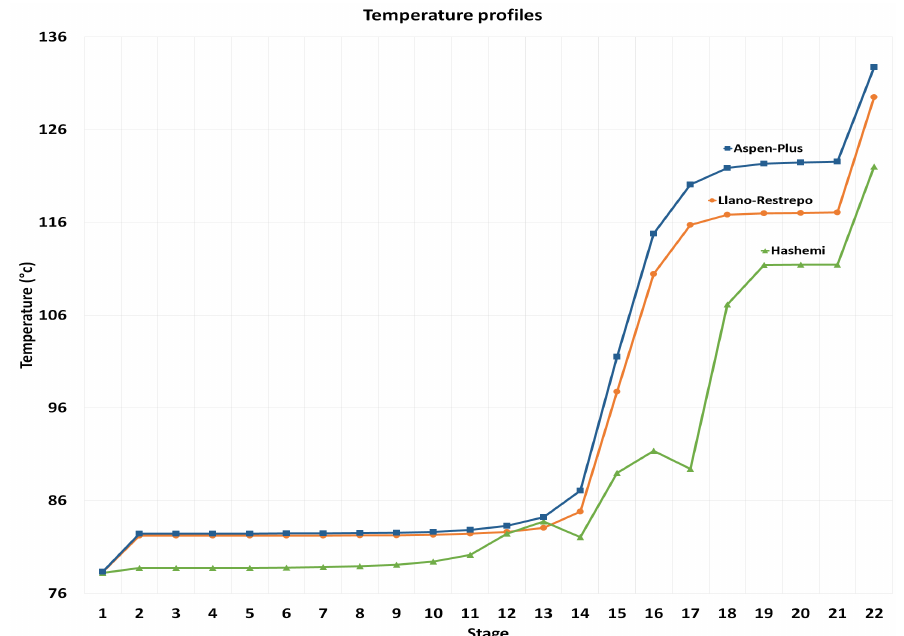
Figure 2. Temperature profiles of the salt extractive distillation column. Comparison between Llano-Restrepo et al. [26] and Hashemi et al.